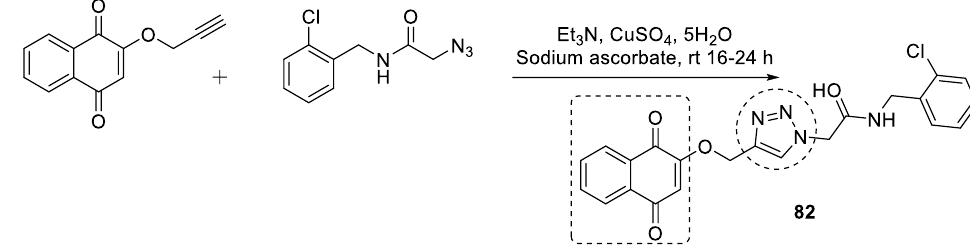
Figure 28. Chemical structure of 1,4 naphthoquinone – 1,2,3-triazole hybrid.